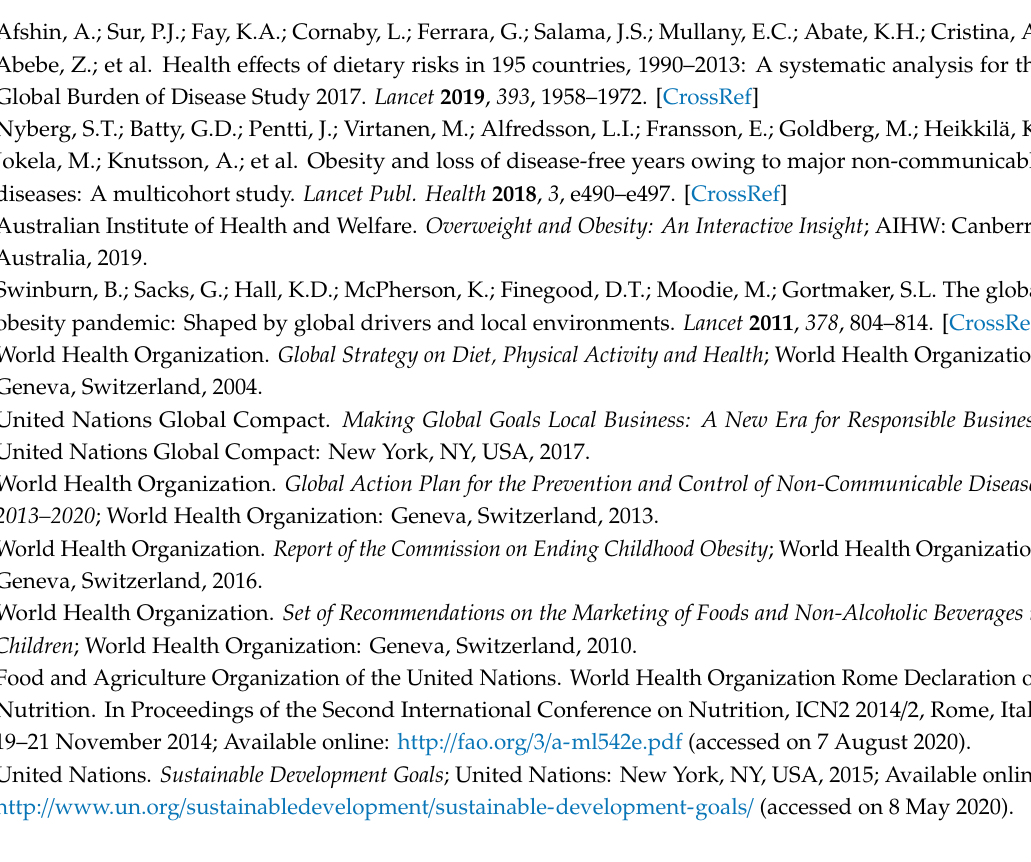
Table S1: BIA-Obesity Australia 2018 assessment tool for packaged food and beverage manufacturers; Table S2: BIA-Obesity Australia 2018 assessment tool for supermarkets; Table S3: BIA-Obesity Australia 2018 assessment tool for quick service restaurants; Table S4: Good practice examples by domain; File S1: Company scorecards (packaged food and beverage manufacturers, supermarkets, quick service